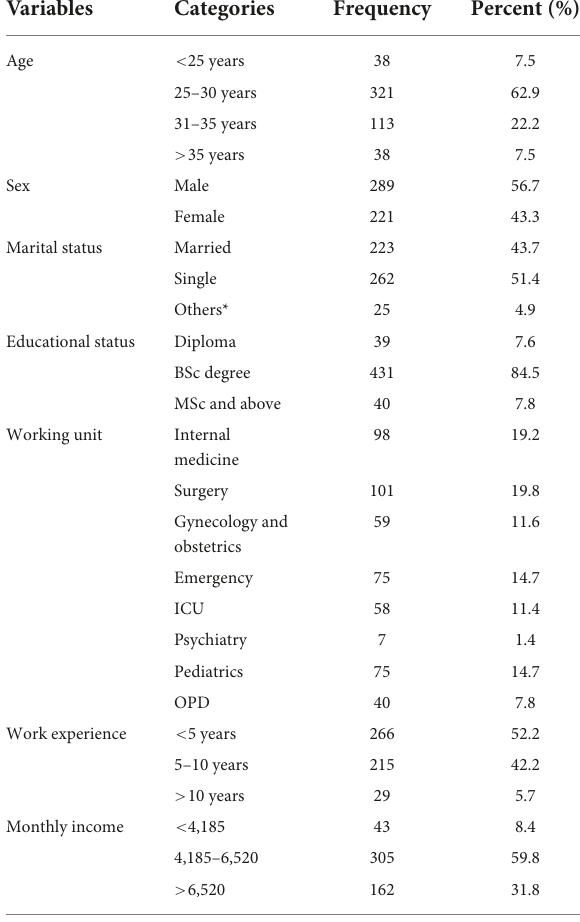
TABLE 1 Socio-demographic characteristics of nurses working at comprehensive specialized hospitals in Northwest Ethiopia, 2021 ( n =